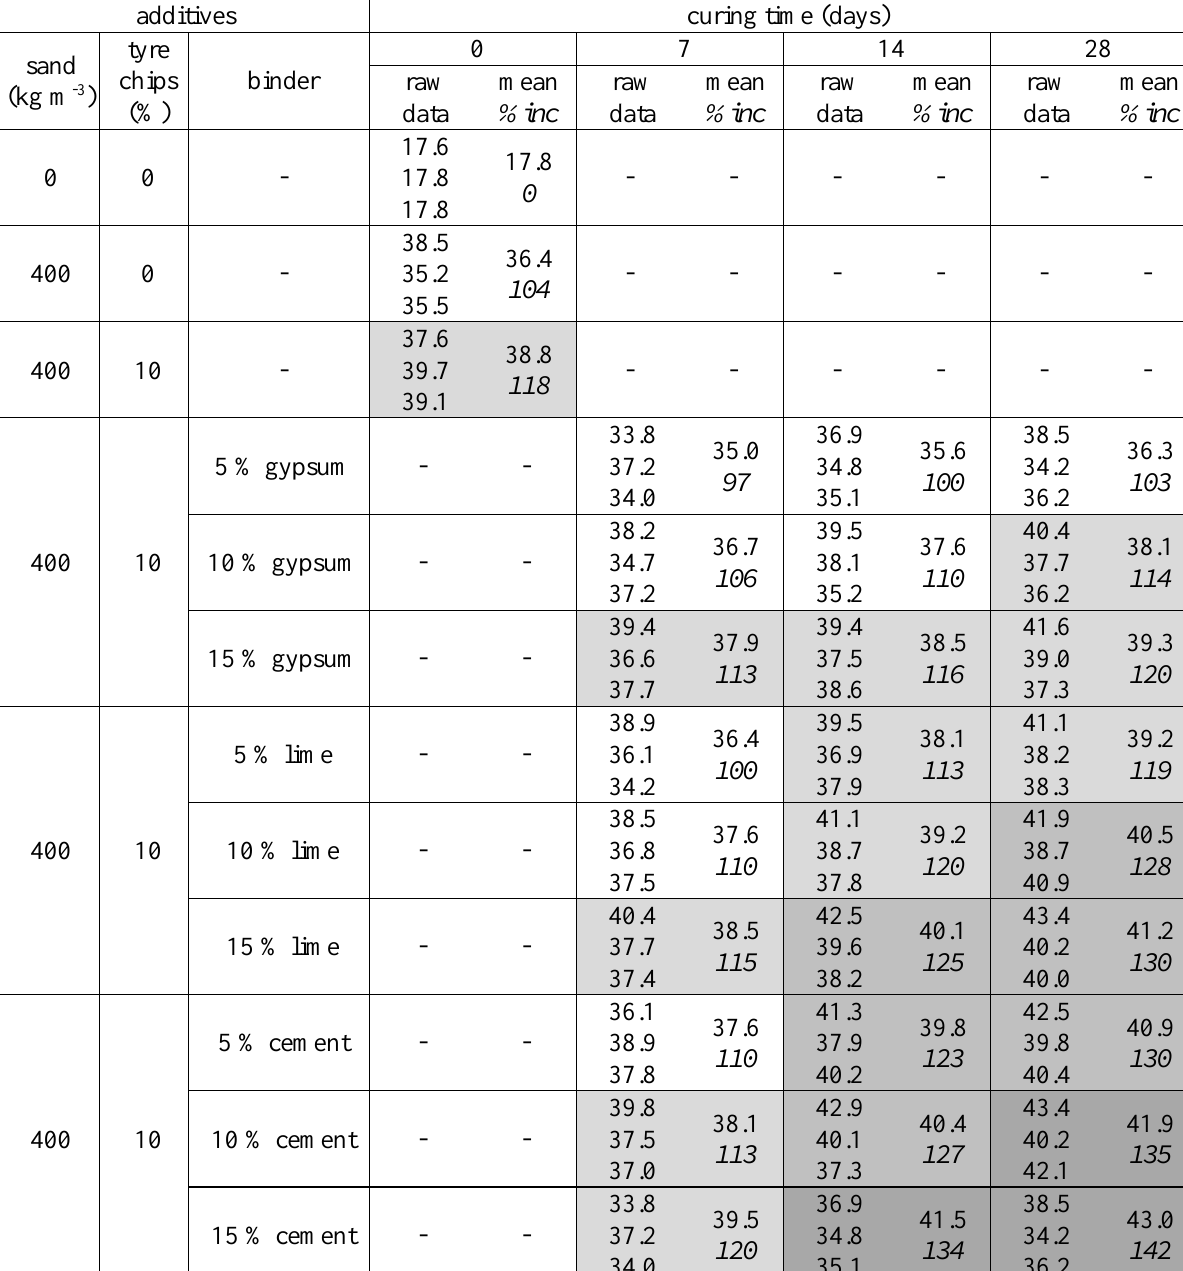
Table A3. Angle of internal friction (φ of Chaghakhor peat with different combinations of additives and curing times irect shear test). For each combination, the test results for the three replicate specimens (raw ) data) are shown on the left, and the mean angle of internal friction value on the right. Beneath each mean value, (from d the figure in italics ( %inc ) is the percentage increase in the parameter compared with untreated peat (top row). The data for specimens without supplements (top three rows) are taken from Rahgozar & Saberian (2016). The results of all 81 of the direct shear tests carried out during this study are shown in the bottom nine rows of the Table. Shading indicates the improvement in φ achieved: no shading indicates an improvement of ≤ 110